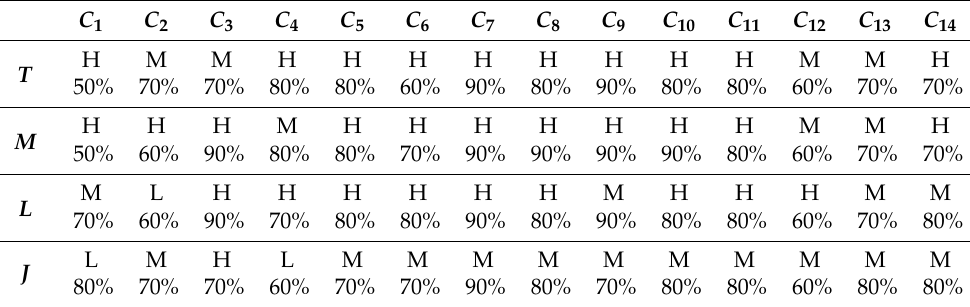
Table A2. Confidence-based fuzzy assessments for the four TPPs (Expert